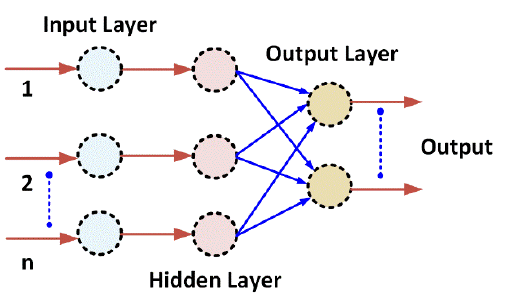
Figure 22. Schematic diagram of an Artificial Neural Network.